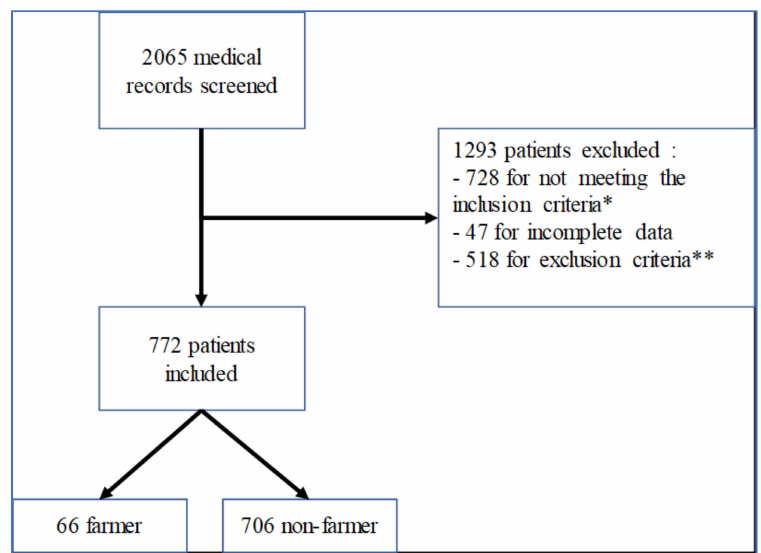
Figure 1. Flow chart of the study: * identifies patients followed for papillary excavation without ocular hypertension nor visual field impairment, patients followed due to a POAG family history with normal clinical examination, nonglaucomatous optic neuropathy, monitoring of treatment with drug-induced optic neuropathy, and nonorganic disorders; ** identifies any types of glaucoma except POAG, thyroid-associated orbitopathy, peripheral retinal damage or maculopathy, pathologic high myopia, and low BCVA unrelated to